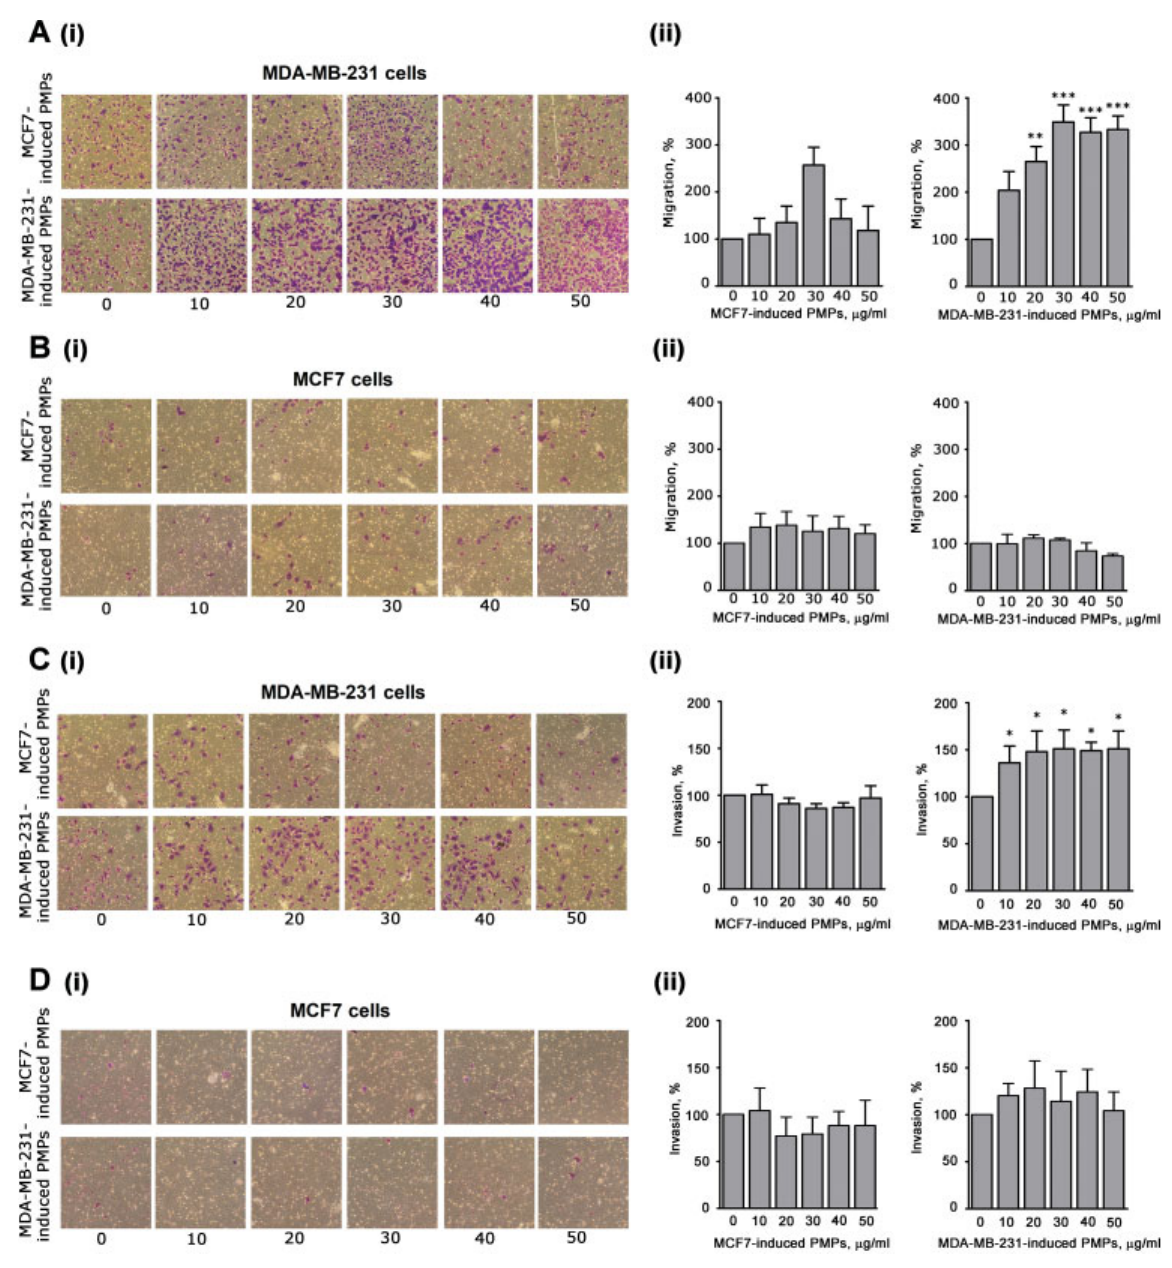
Fig. 4 Analysis of cell migration and invasion. Effect of MCF7- or MDA-MB-231-induced PMPs (as indicated on the left) on migration (panels A and B) and invasiveness (panels C and D) of MDA-MB-231 cells (panels A and C) or MCF7 cells (panels B and D), as indicated. Cancer cells were treated with increasing amounts of the two different types of PMPs preparations (0 – 50 μ g/mL, as indicated on the bottom) and then transferred inside cell culture inserts. For the invasionassays(panelsCandD),theuppersideoftheinsertwascoatedwith0.1mLofMatrigel(50µg/mL).Incubationwasprolongedfor18hoursandthecells that moved through the porous membrane were stained and counted. In all the panels, representative images are reported in (i), while quanti fi cation of the results is shown in (ii) as mean (cid:4) SEM of three experiments. Statistical signi fi cance of the difference was calculated between treated and untreated cells (sample 0). (cid:1) p < 0.05; (cid:1)(cid:1) p < 0.01; (cid:1)(cid:1)(cid:1) p <